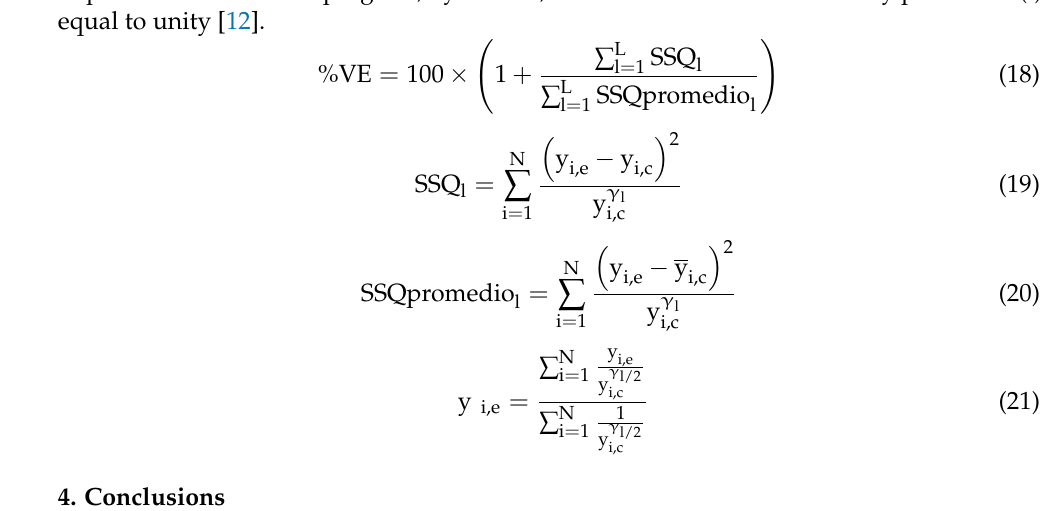
Table S1: Kinetic runs performed for the anhydrous triphasic system; Tables S2–S5: Experimental results of the enzymatic esterification of glycerin with ibuprofen immobilized enzyme N435 at T = 50 ◦ C for the anhydrous system (50–80 ◦ C); Table S6: Kinetic runs performed for the